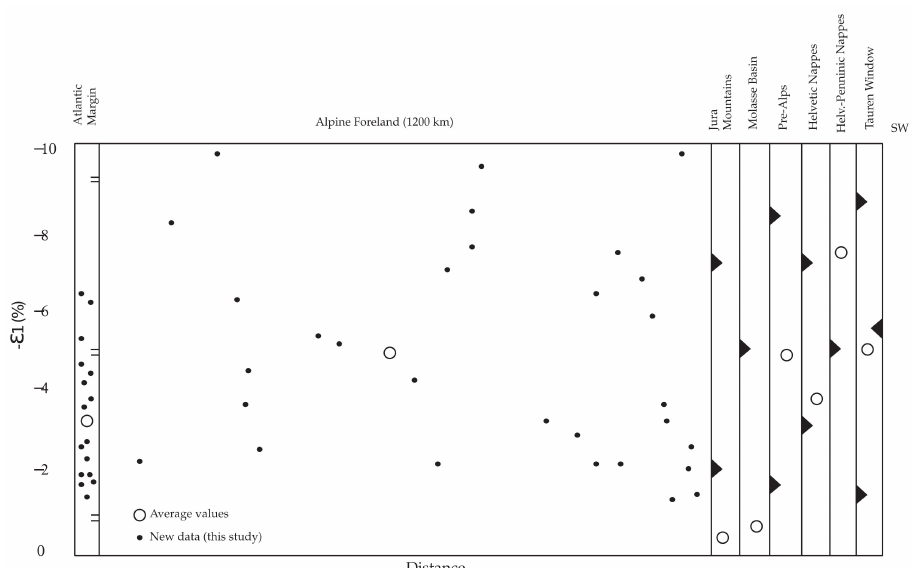
Figure 9. Plot of calcite twinning shortening strain (-e1) across the Alps, the Alpine foreland and the older (58 Ma) divergent Atlantic margin in Ireland.